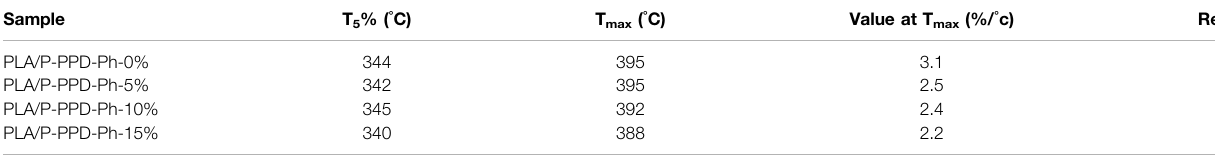
TABLE 1A | (A) TG and DTG data of PLA and PLA-conjugated fl ame-retardant composites derived from TG analysis. Sample